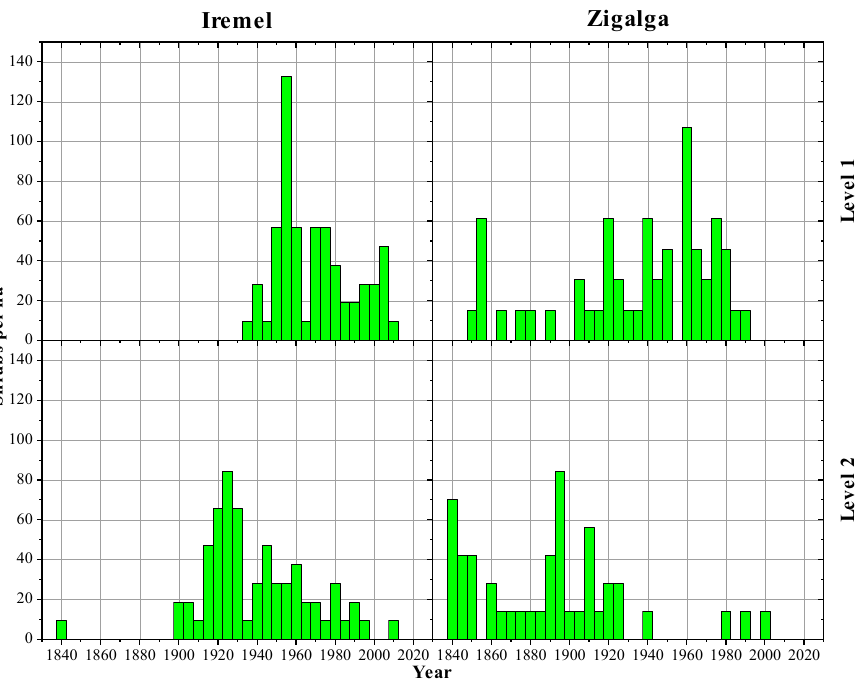
Figure 8. Age structures of J. sibirica on Iremel and Zigalga, Southern Urals. Levels 1 and 2 correspond to high and mid elevations, respectively.